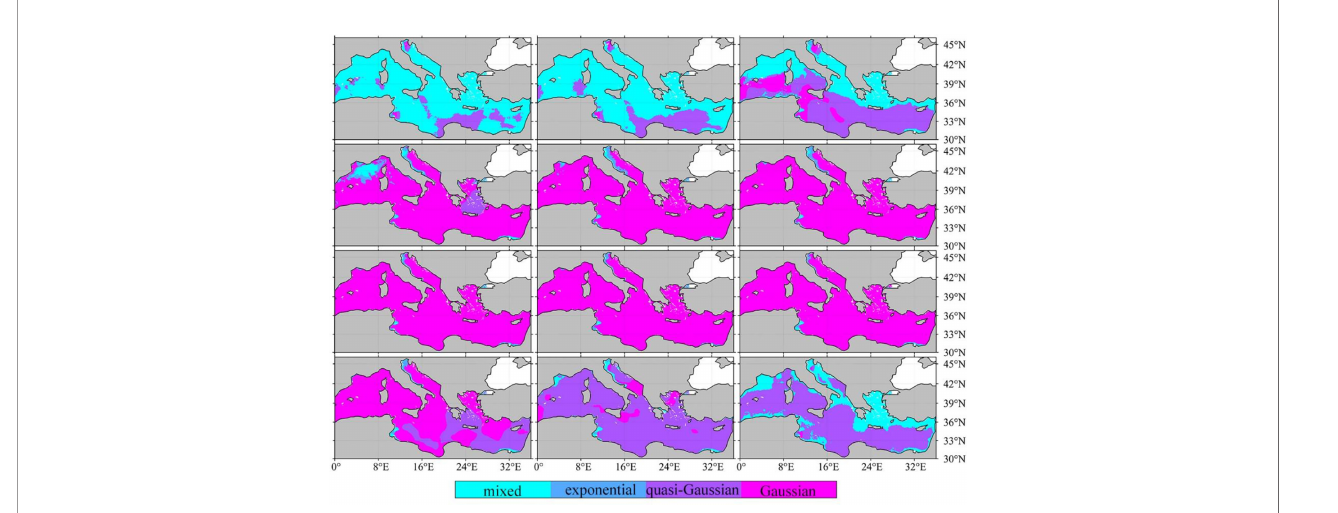
FIGURE 13 | Monthly Chl-a pro fi le types in the Mediterranean Sea in 2013. The subgraphs show January to December from top to bottom and left to right.